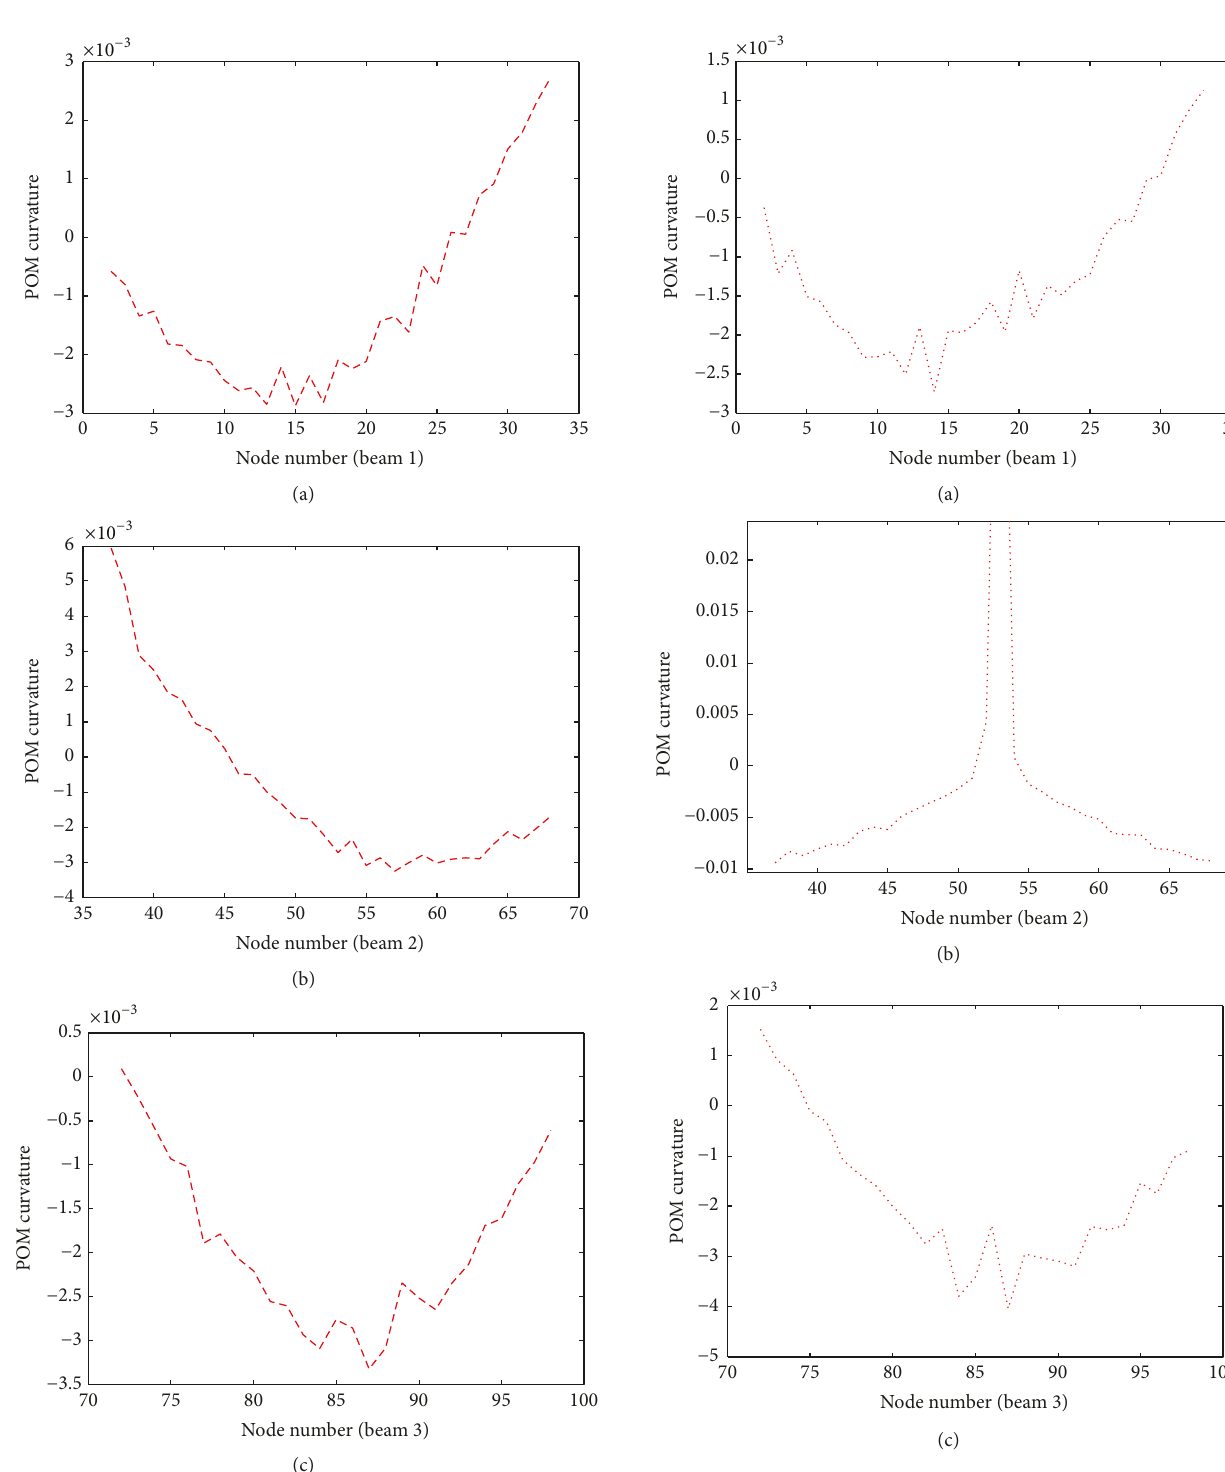
Figure 10: POM curvature curves using FRFs in the region (E) containing 1% external noise: (a) beam 1, (b) beam 2, and (c) beam